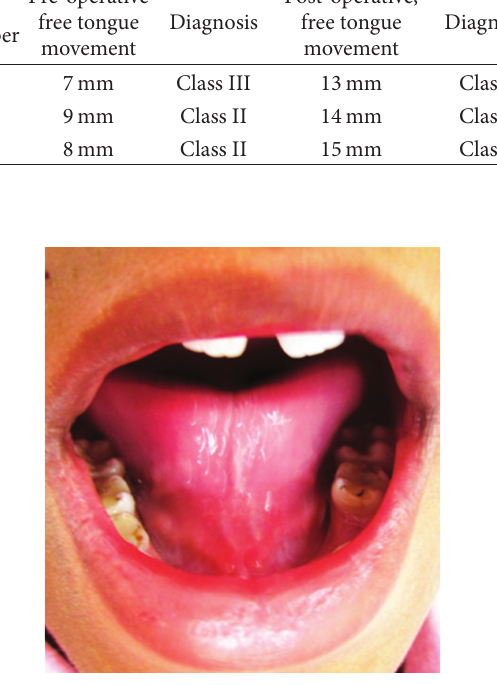
F 9: Postoperative photograph aer 1 year (Case